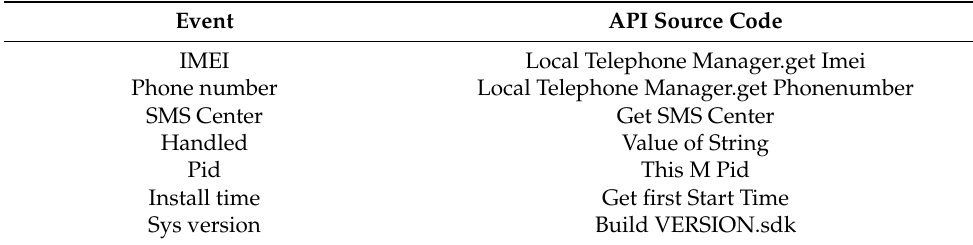
Table 2. A typical high-risk API source